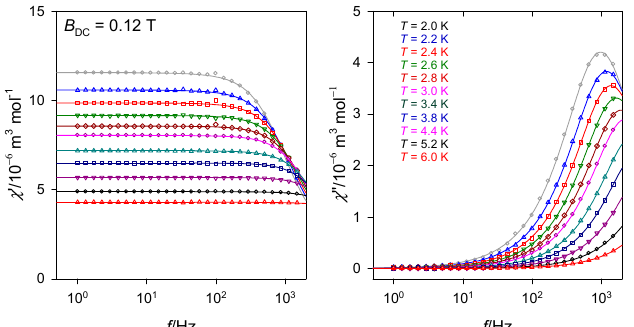
Figure 7. Frequency dependence of the AC susceptibility for 1 for a set of temperatures at B DC = 0.12 T.